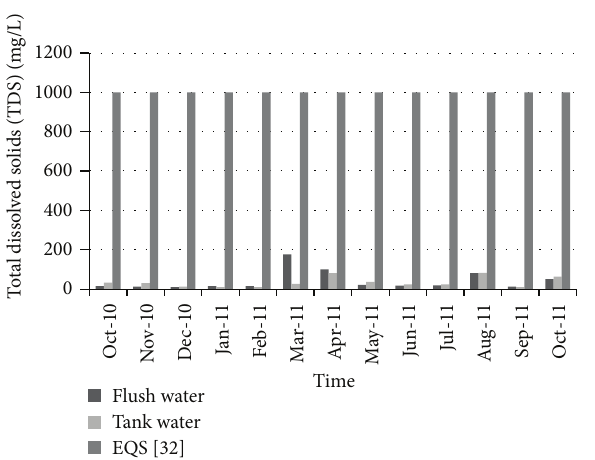
Figure 12: Variation of total dissolved solids over time.